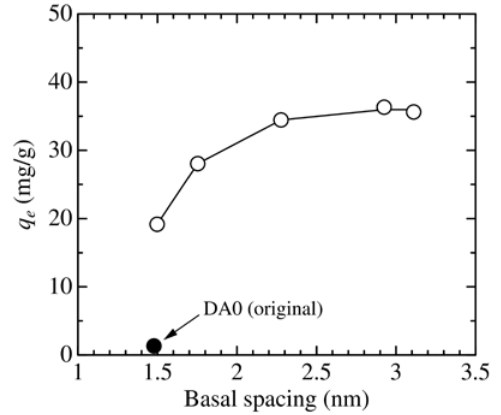
Figure 7. Relationship between equilibrium adsorption capacity and basal spacing (dosage = 0.5 g/L, initial concentration = 20 mg/L, initial pH = 6.9, temperature = 301 K).